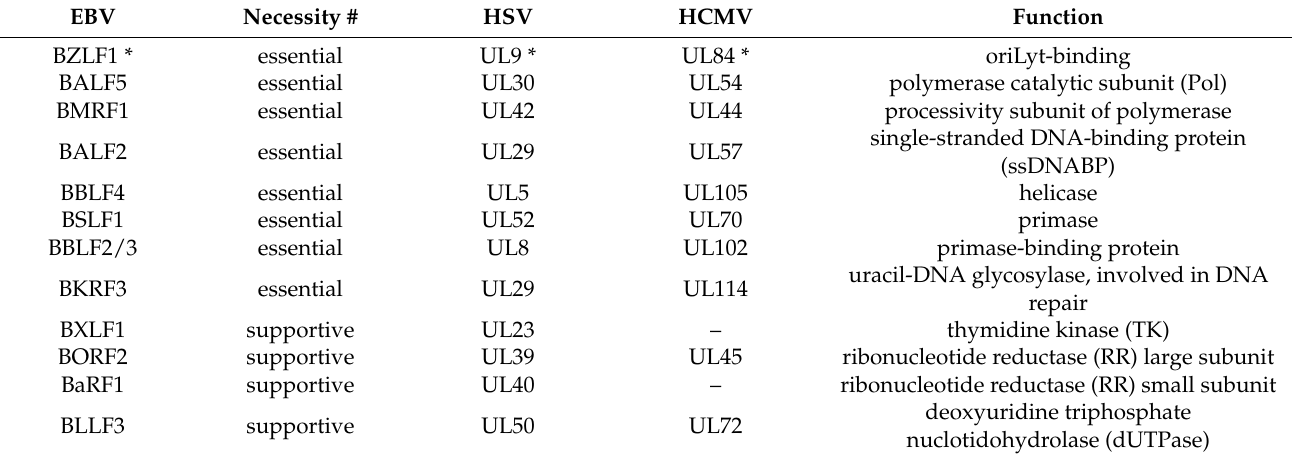
Figure 4. Schematic diagram of EBV lytic cycle. Lytic induction results in a coordinated cascade of viral gene expression and viral DNA replication, followed by encapsidation, envelopment, and progeny production. Red line indicates viral genome. Green, orange, and blue circles represent viral IE, early, and late gene products, respectively. TGN, trans -Golgi network. Modified from [111]. Table 3. Herpesviral genes involved in viral lytic DNA synthesis.